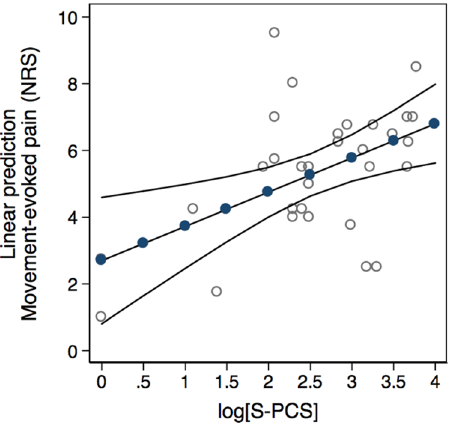
Figure 4. Preoperative conditioned pain modulation and postoperative morphine consumption. Adjusted means (filled circles) with 95% confidence intervals (continuous solid lines) of the patient’s postoperative morphine consumption given different values of preoperative conditioned pain modulation (CPM %). The hollow circles represent overlaid scatterplots of CPM % versus postoperative morphine consumption.